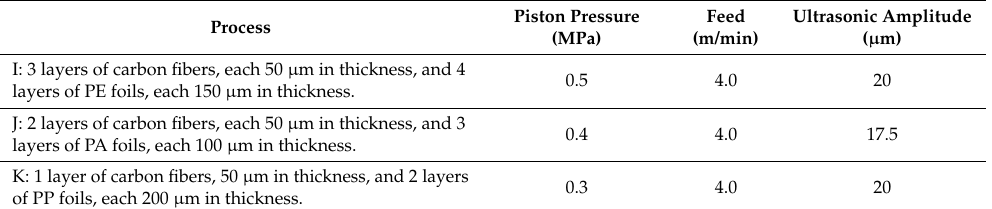
Table 4. Overview of the process conditions and the parameters for the ultrasonic fabrication of CFRP by the CERA 100 ultrasonic welding machine.